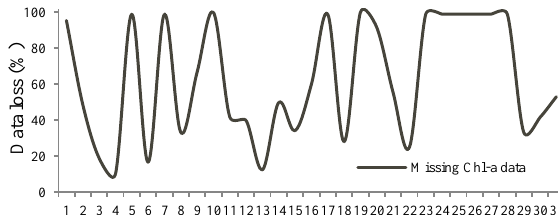
Figure 3. Percentage of uncertainty in the MODIS Aqua chl- a data acquired during the cyclonic events. The cyclone cases are specified in Table 1 in ascending order as per the year